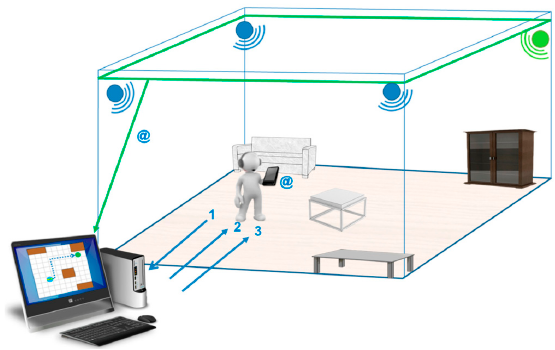
Figure 40. The system’s installation inside a room [61].